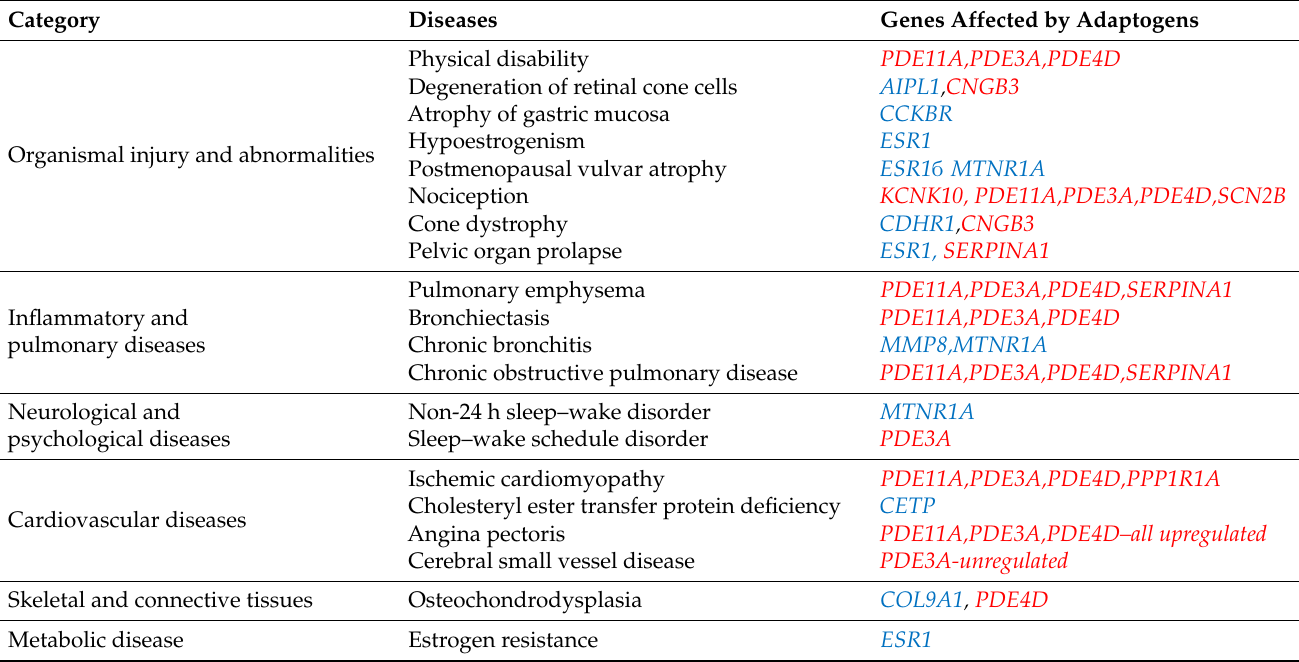
Table 5. Age-associated diseases and genes involved in their pathogenesis and progression that are significantly regulated by adaptogens; downregulated genes are in blue and upregulated ones are in red colors; adapted from Reference